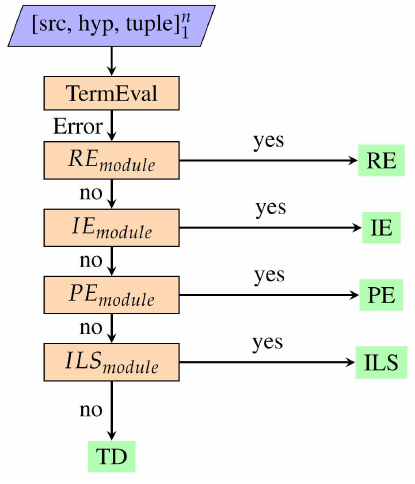
Figure 3. Flowchart of